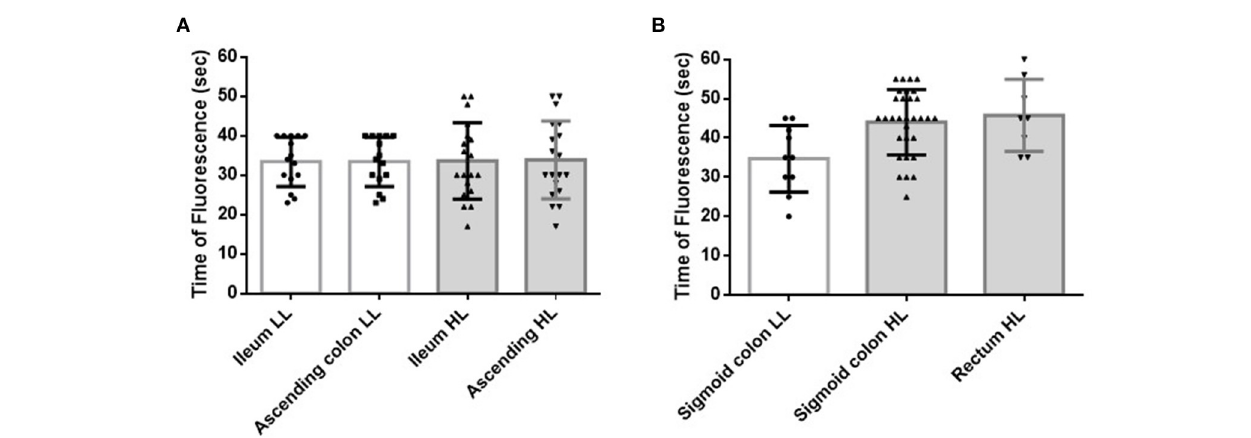
FIGURE 3 | Effect of the level of ligation of the main artery on the blood flow of the bowel stumps during surgery. (A) Effect of the level of ligation of the ICA during ICR. HL of the ICA did not affect the FT of the ileal or ascending colon stumps ( p = 0.860 and p = 0.934, respectively). (B) Effect of the level of ligation of the IMA during AR. HL of the IMA significantly prolonged the FT of the sigmoid colon ( p = 0.004). All patients with a measurable rectal stump blood flow received HL of the IMA. ICA, ileocecal artery; ICR, ileocecal resection; HL, high ligation; FT, fluorescence time (time from indocyanine green injection and injection route flush to the time at which the strongest fluorescent signal was observed in the stump); IMA, inferior mesenteric artery; AR, anterior rectal resection; LL, low ligation.